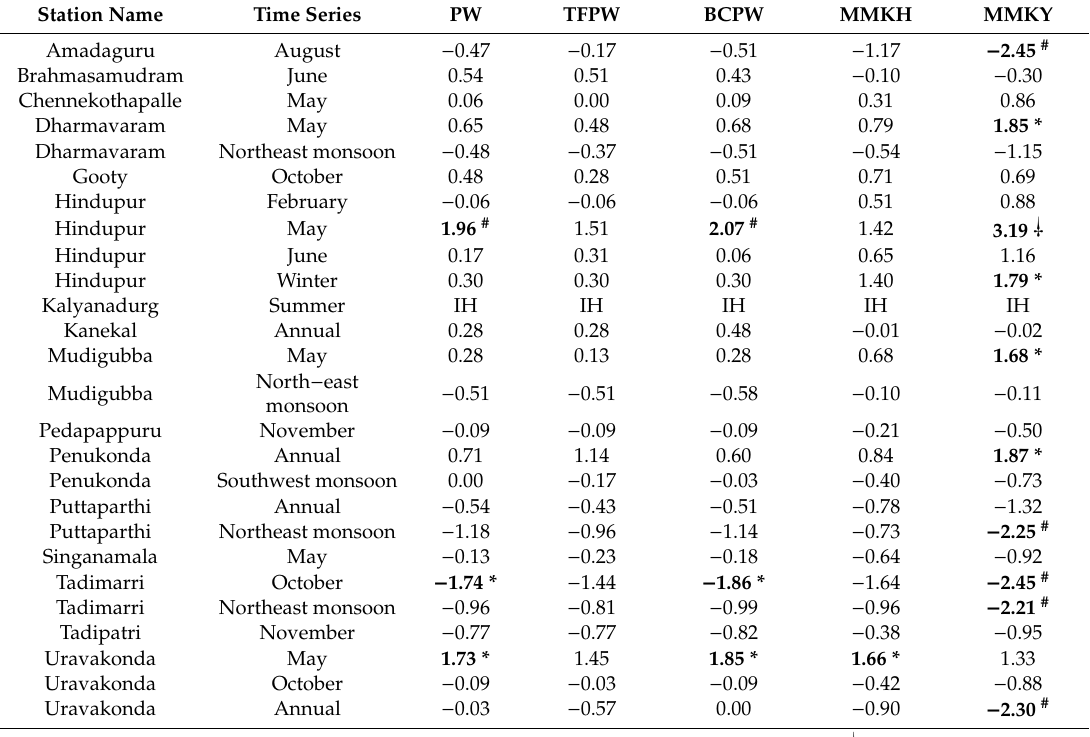
Table 4. Results of modified versions of the Mann–Kendall test applied to serially correlated